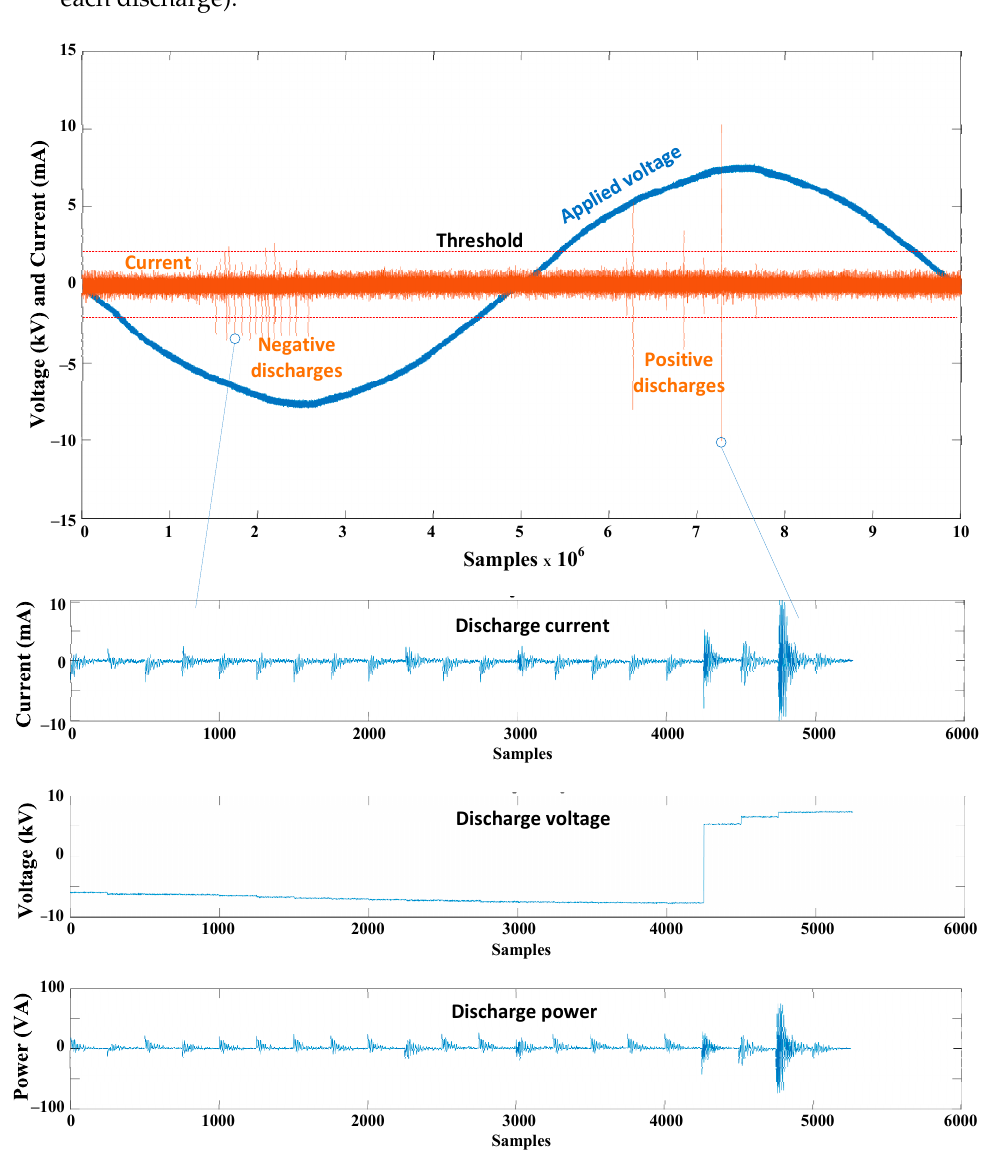
Figure 2. Applied data processing strategy to determine the energy dissipated by the discharges.